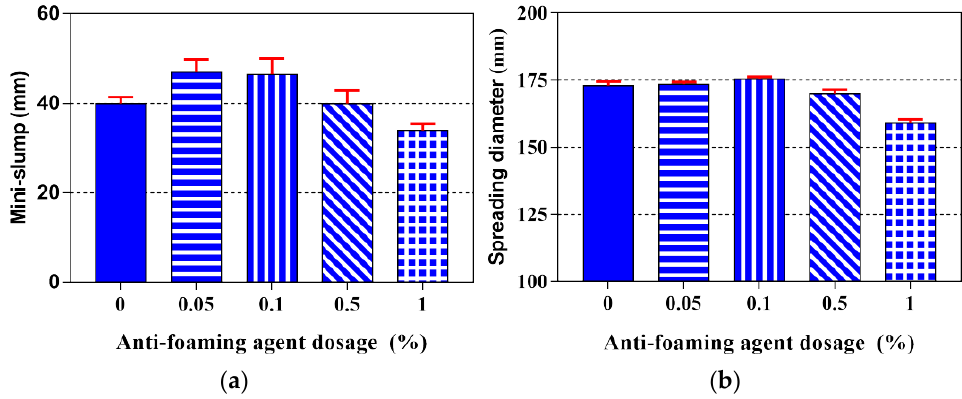
Figure 4. Influence of AFA dosage on the ( a ) mini-slump and ( b ) spreading diameter of 3DPC.